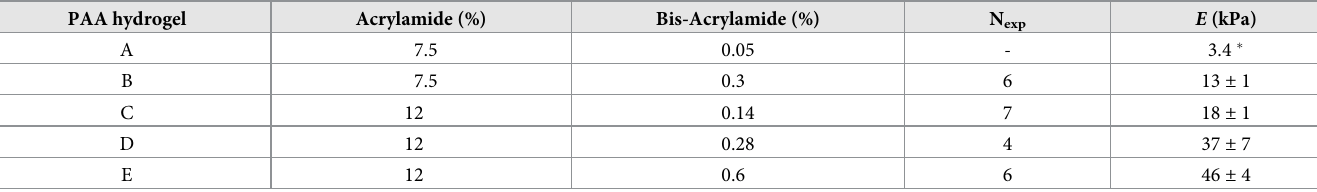
Young’s modulus, E , measured averaging the results of force-distance curves obtained in N exp experiments. More than 1000 curves were analyzed for each PAA composition. Errors represent the standard error (SE).